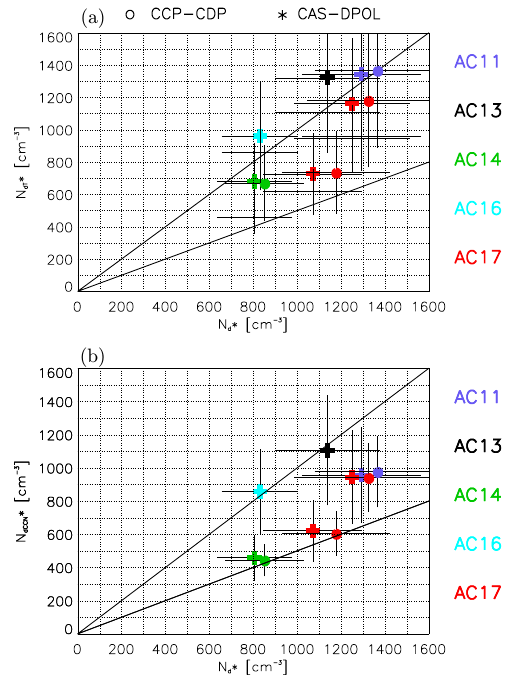
Figure 14. (a) Mean volume drop mass ( M v ) vs. liquid water Figure 13. (a) N ∗ vs. N ∗ calculated with W ∗ from the cloud base content from the CCP-CDP measurements for adiabatic fractions d dT b data shown in Figs. 11 and 12. The CAS-DPOL values are indicated greater than 0.25 (LWC a ). Values are shown with different colors by plus symbols ( + ) and the CCP-CDP values are indicated by cir- labeled as a function of height in kma.s.l. (kilometers above sea cles (o). The colors indicate each flight segment (legend on the right level; indicated by the color bar on the right side of the figure). The side of the plot). The error bars indicate the uncertainties in variable slope of the linear equation is the estimated N a (i.e., 1496cm − 3 ) . estimates. The lines show the 1:1 and 1:2 relationships between (b) M v vs. r e as a function of height in kma.s.l. (indicated by the N ∗ vs. N ∗ for each probe. (b) The same for N ∗ vs. N ∗ . color bar on the right side of the dT d d dCCN